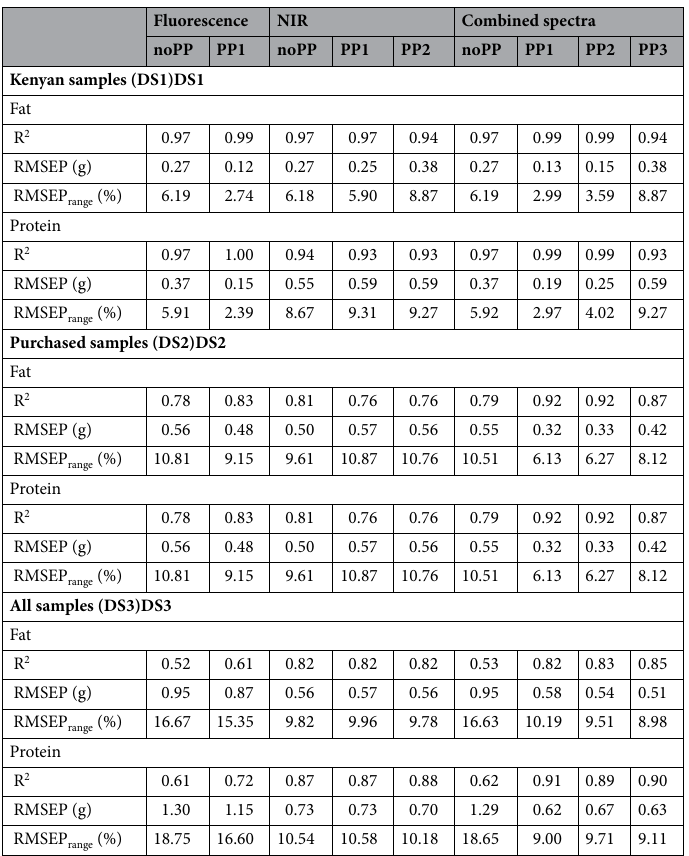
Table 3. Results of the PLSR model prediction of fat and protein of chia seeds with single and combined spectra of fluorescence and NIR with no and the three pre-processing variations and all three datasets (DS). R 2 is the coefficient of determination, RMSEP is the absolute root mean squared error of prediction, RMSEP range is the percentage error. PP indicates pre-processing, PP1: SNV, PP2: SNV and baseline correction, PP3: SNV, baseline correction and reducing factor for fluorescence spectra. PP is for pre-processing.